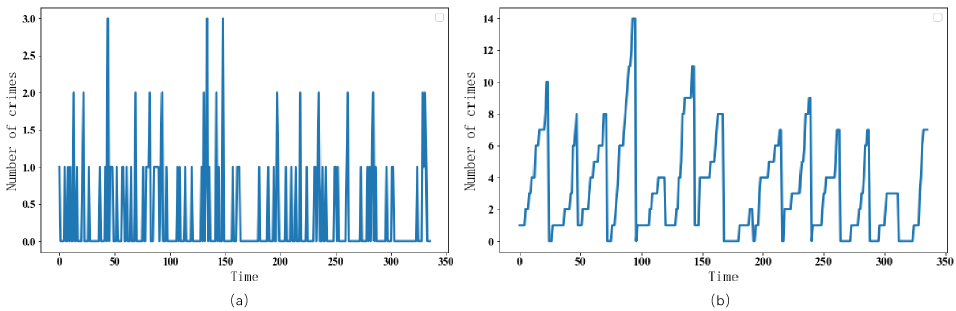
Figure 4. The hourly crime time series over the last two weeks in a randomly chosen grid: ( a ) hourly crime time series on the grid [ 34.2000 ◦ ,34.025 ◦ ] × [ − 118.325 ◦ , − 118.3 ◦ ] ; ( b ) integrated hourly crime time series corresponding to ( a